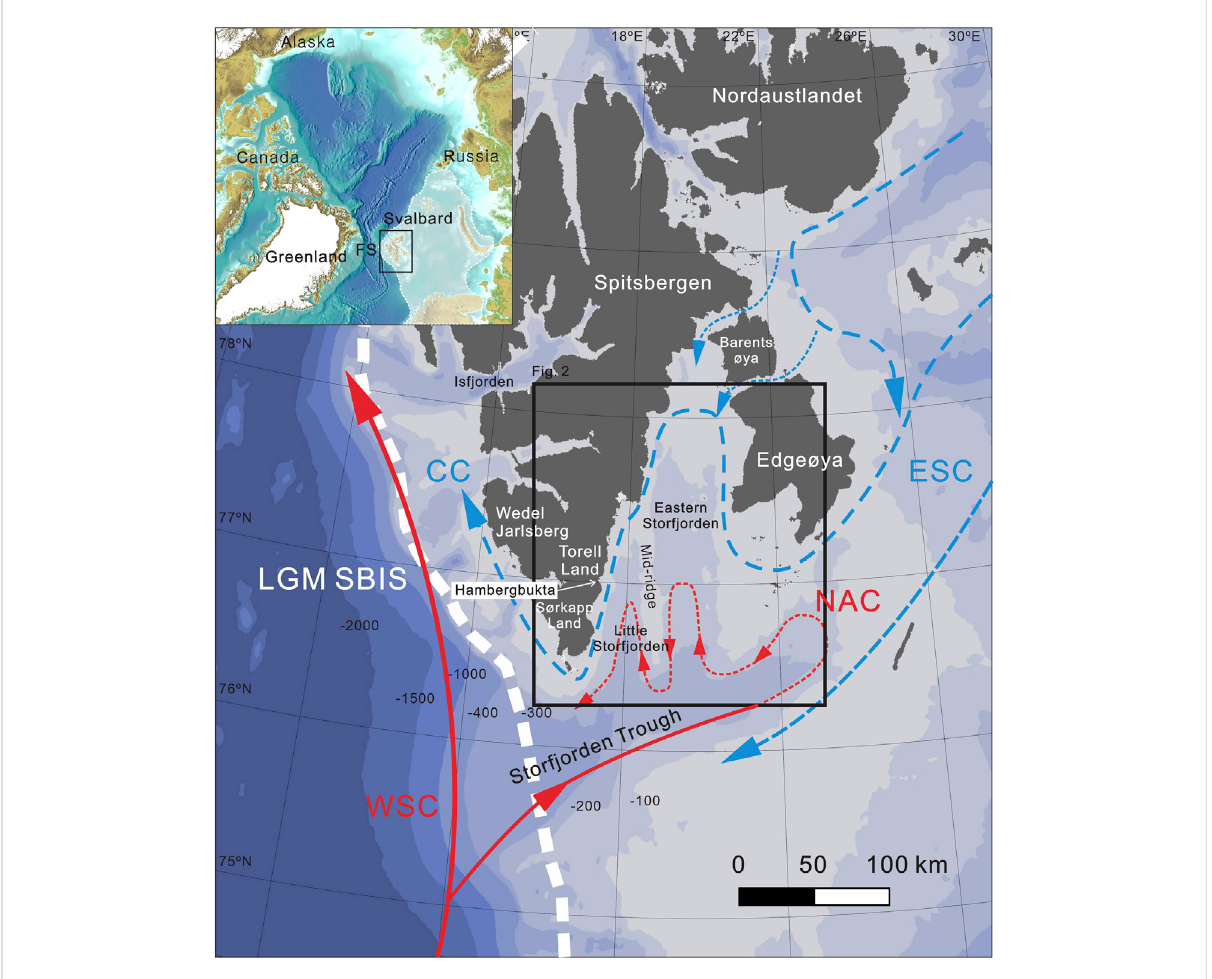
FIGURE 1 Physiographicmap of the Arctic Ocean (upper leftpanel) and Svalbard located east of the Fram Strait(FS). The oceancirculationpatternsof the East Spitsbergen Current (ESC)/Coastal Current (CC) and West Spitsbergen Current (WSC)/Norwegian Atlantic Current (NAC) were based on Skogseth et al. (2005). Coinciding with a semi-transparent area in the upper left panel, the white dashed line indicates the Last Glacial Maximum (LGM) extent of the Svalbard-Barents Seas Ice Sheet (SBIS) referred from Hughes et al.